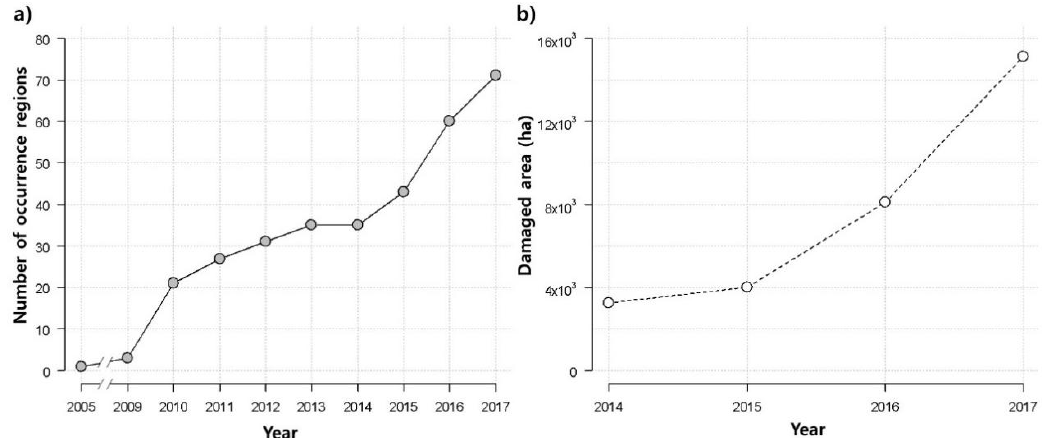
Figure 2. Change in ( a ) the number of occurrence regions and ( b ) area damaged by Metcalfa pruinosa in South Korea. Data were from databases (Gyeonggi-do Agricultural Research Services (https://nongup.gg.go.kr) and the Ministry of Agriculture, Food, and Rural Affairs (http://www.mafra.go.kr)). Damaged area data in Figure 2b were only available from 2014.